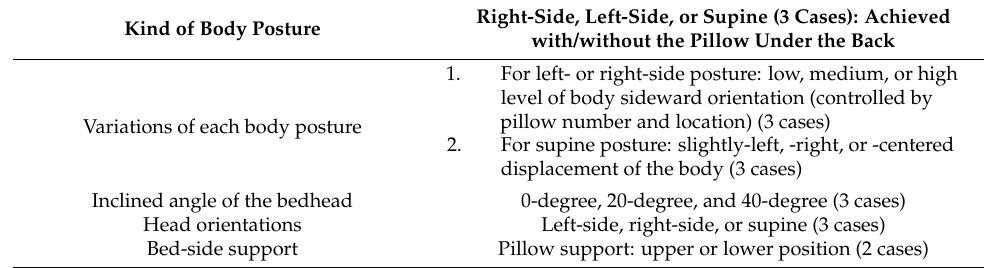
Table 2. Changing factors in collecting the posture